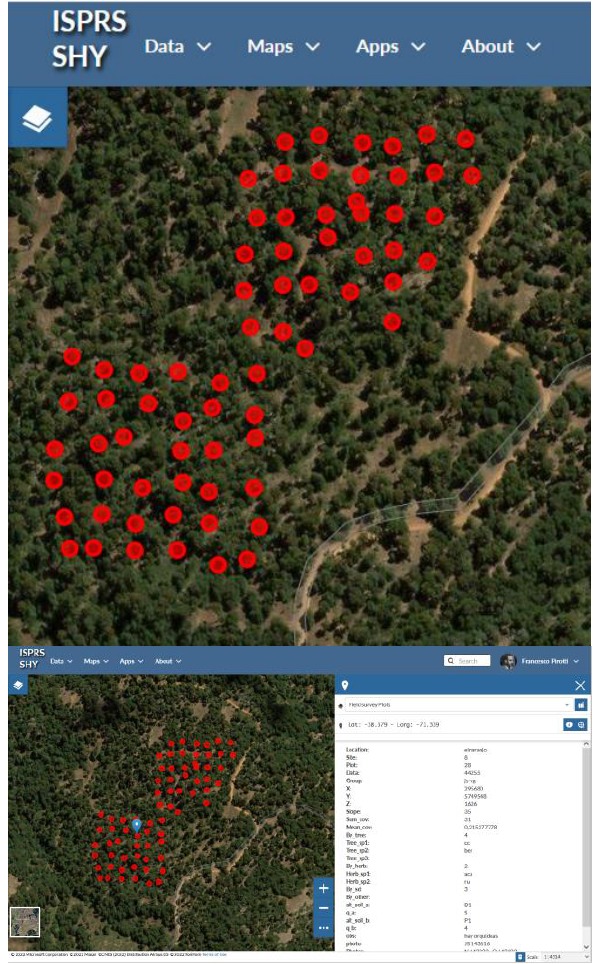
Figure 5. Example of project group users, with description of the project.